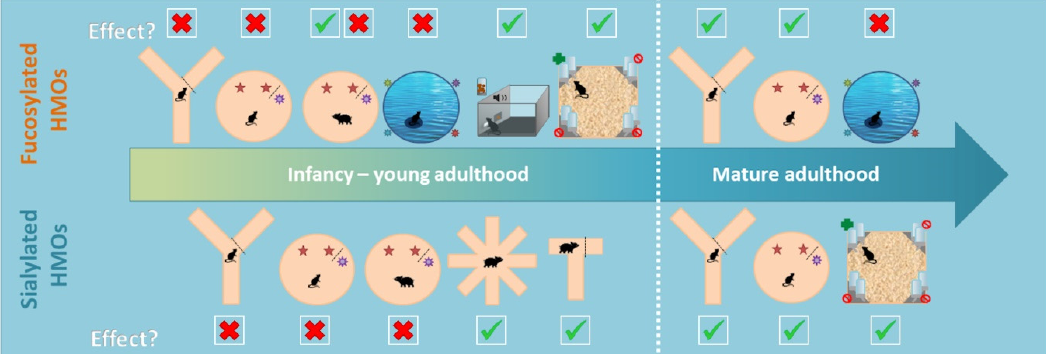
Figure 2. Graphical summary of behavioural tests results. The results have been grouped based on the type of HMO (Fucosylated versus Sialylated), animal model (rodents versus piglets) and the age of when the behavioural test has been performed. Infancy–young adulthood has been defined as the period ranging from PND1–6 months of age, while mature adulthood encompasses animals of 1 year old. Red crosses indicate that no significant differences were observed between the HMO and the control group, while green check marks indicate that positive effects due to HMO supplementation were reported. Details on the nature of such effects are summarized in Table 1.